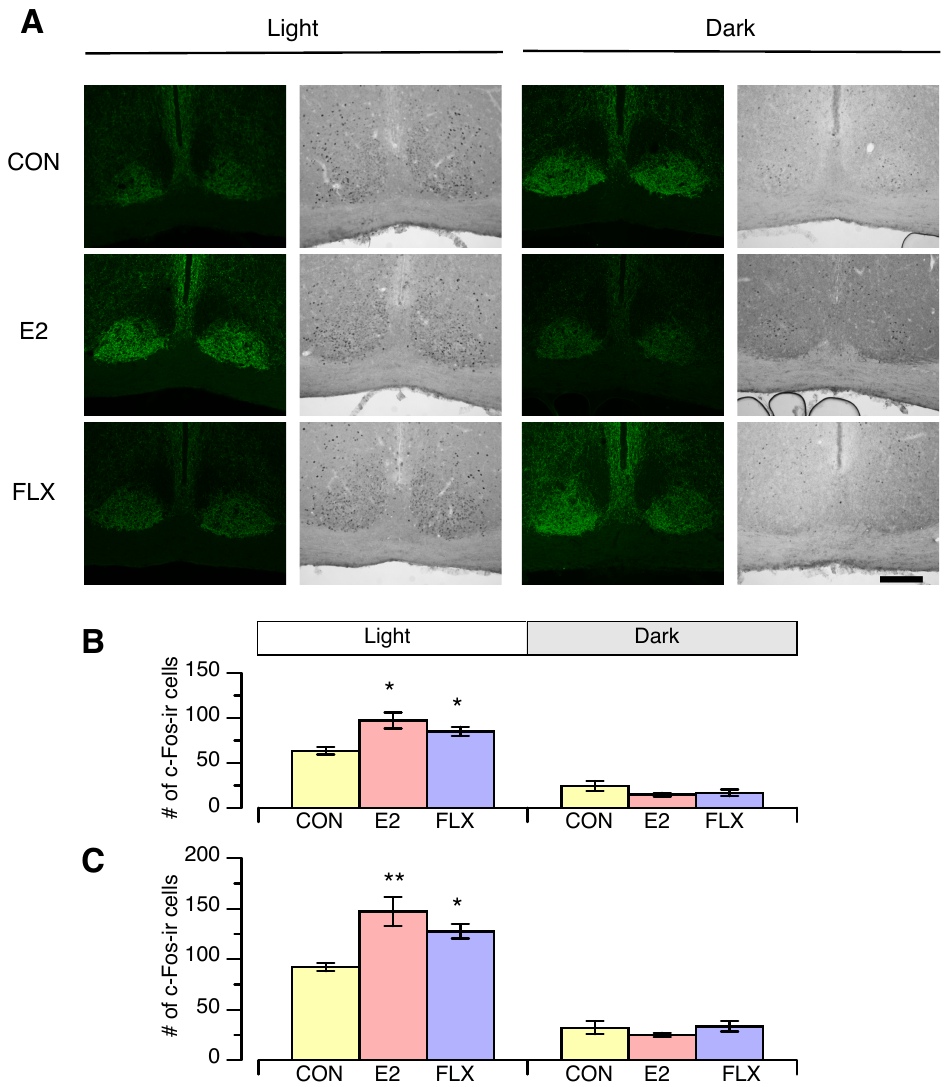
Figure 5. The e ff ect of estradiol or fluoxetine on c-Fos expression in the suprachiasmatic nucleus (SCN) during the light phase (ZT3-7) and dark phase (ZT15-19) in ovariectomized female rats. ( A ): Representative microscope images of c-Fos-immunoreactive (ir) nuclei and neuropeptide Y (NPY) immunoreactivity in the SCN during the light phase and dark phase. Scale bar = 200 µ m. ( B ): Number of c-Fos-ir nuclei in the ventrolateral SCN during the light phase and dark phase. ( C ): Number of c-Fos-ir nuclei in the whole SCN during the light phase and dark phase. Female rats were ovariectomized and assigned to the estradiol- or cholesterol-treated group. Six or seven days after ovariectomy, half of the cholesterol-treated rats were subcutaneously ( s.c. ) injected twice daily with 5 mg / kg fluoxetine (FLX) at ZT0 and ZT12, while the other half of the cholesterol-treated rats (CON) and all of the E2-treated rats (E2) were s.c. injected with the same volume of saline. Samples were obtained on day 10 of FLX treatment. Data are shown as the mean ± SEM ( n = 9 in CON, n = 8 in E2, and n = 8 in FLX during the light phase; n = 5 in CON, n = 5 in E2, and n = 6 in FLX during the dark phase). Note: * and **: significant di ff erences at p < 0.05 and p < 0.01, respectively, between the CON and treatment